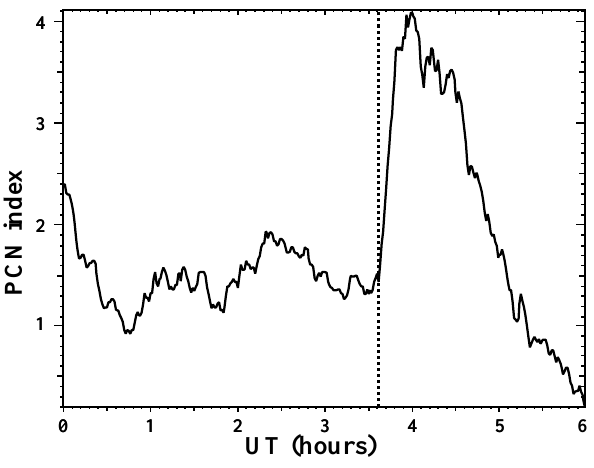
Fig. 8. Variations in the Northern Polar Cap index. Dashed line marks the start of the sudden increase at 03:37 UT.